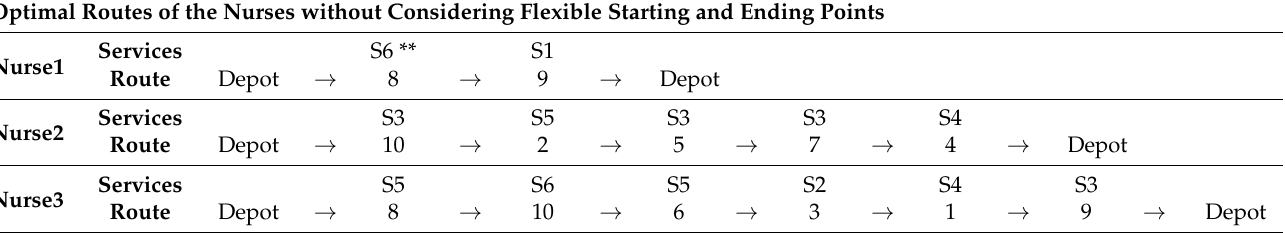
Table 1. Optimal routes without considering flexibility in the model.